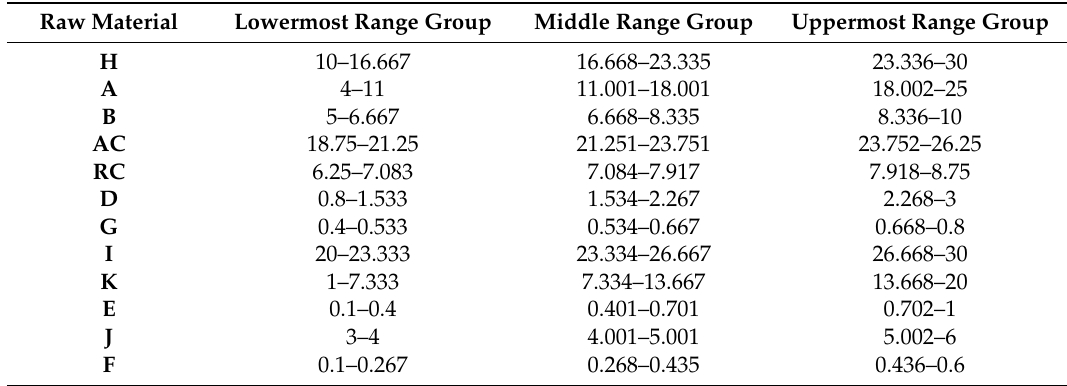
Table 2. Raw material groups (in percentage/100 g).